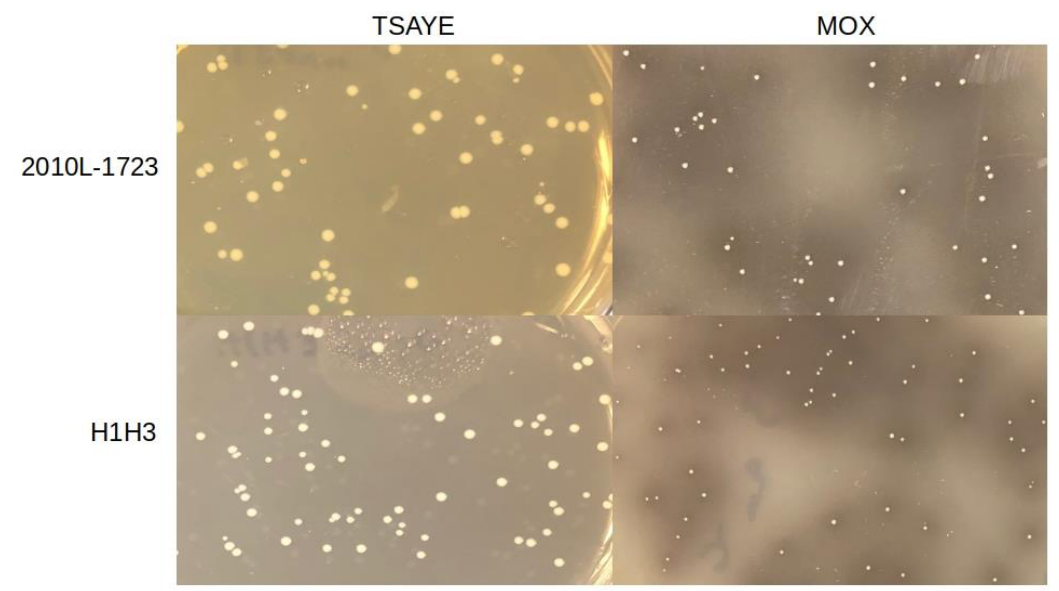
Figure 6. Anaerobic growth of 2010L-1723 and H1H3 under anaerobic conditions. Left panel; TSAYE; right panel, MOX. Strains were grown for 72 h at 37 °C as described in Materials and Methods.